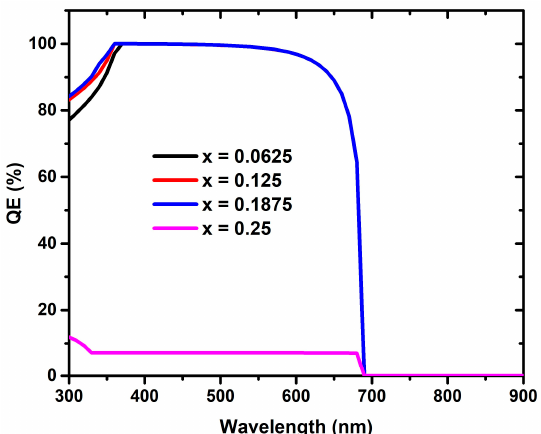
Figure 4 . Quantum efficiency (QE) behavior of the buffer layers under the light spectrum. Therefore, the energy band alignment of C 2 N/ZMO structures demonstrates that a spike (positive CBO) interface helps in improving cell performance. However, a large spike (overly positive CBO) creates a barrier for the photogenerated charge carriers, low- ering the short circuit current ( J sc ) Figure 5 and efficiency.